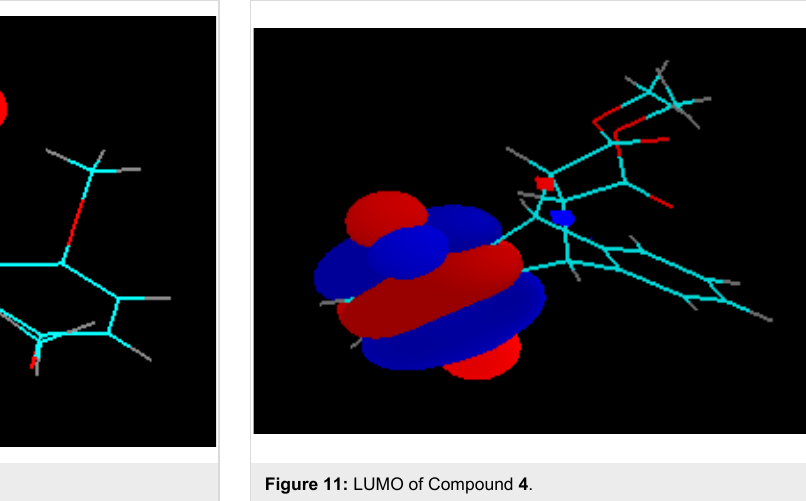
Figure 11: LUMO of Compound 4